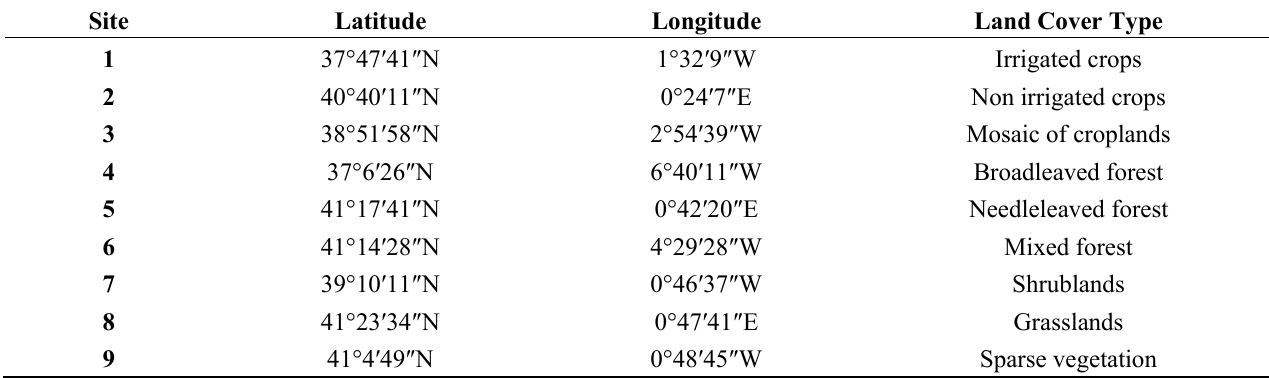
Table 1. List of the nine sites selected for the